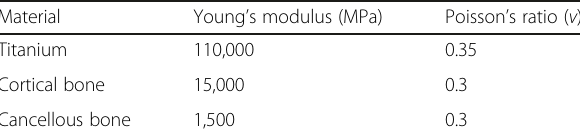
Table 1 Material properties used construction the models